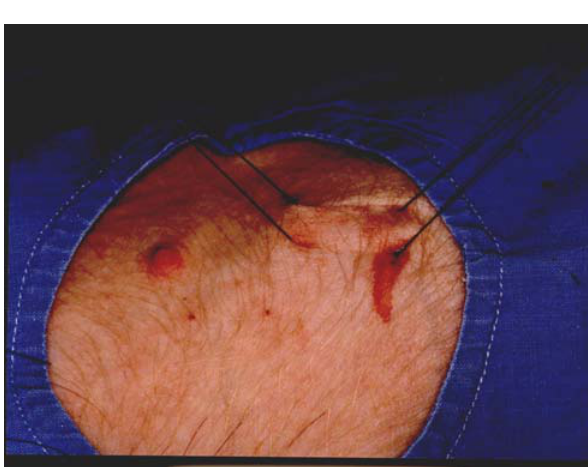
FIGURE 6A - Schematic gastric view: two paralell U stiches anchoring the gastric wall to the parietal peritoneum.